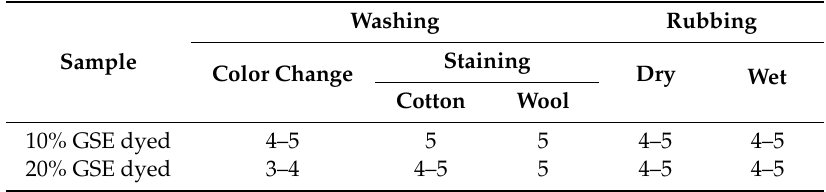
Table 2. Color fastness of cotton fabrics dyed with